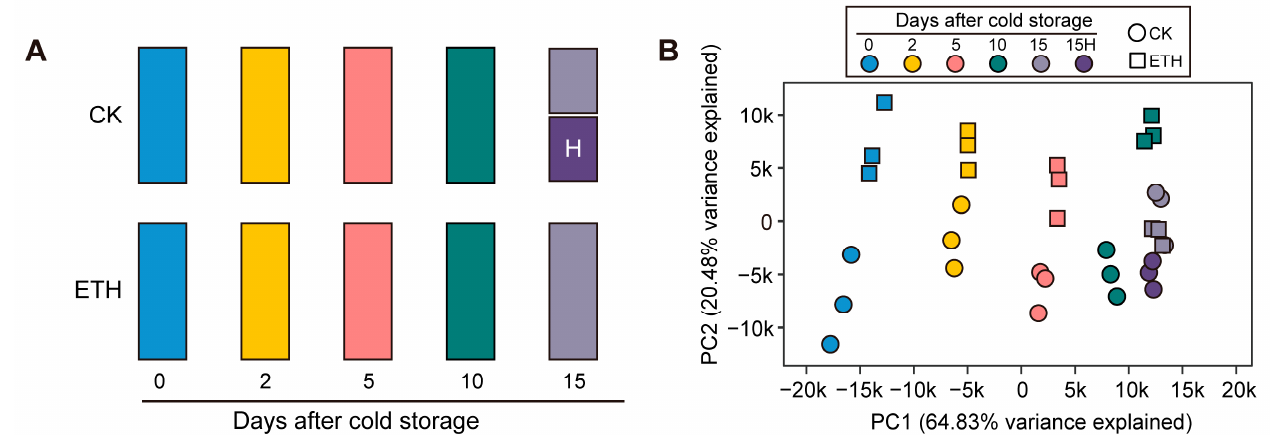
Figure 2. RNA-seq experiment design and principal component analysis (PCA) of sequencing samples. ( A ) The RNA-seq experiment design. For each treatment at each time point, three replicates were set. ( B ) PCA analysis of sequencing samples.